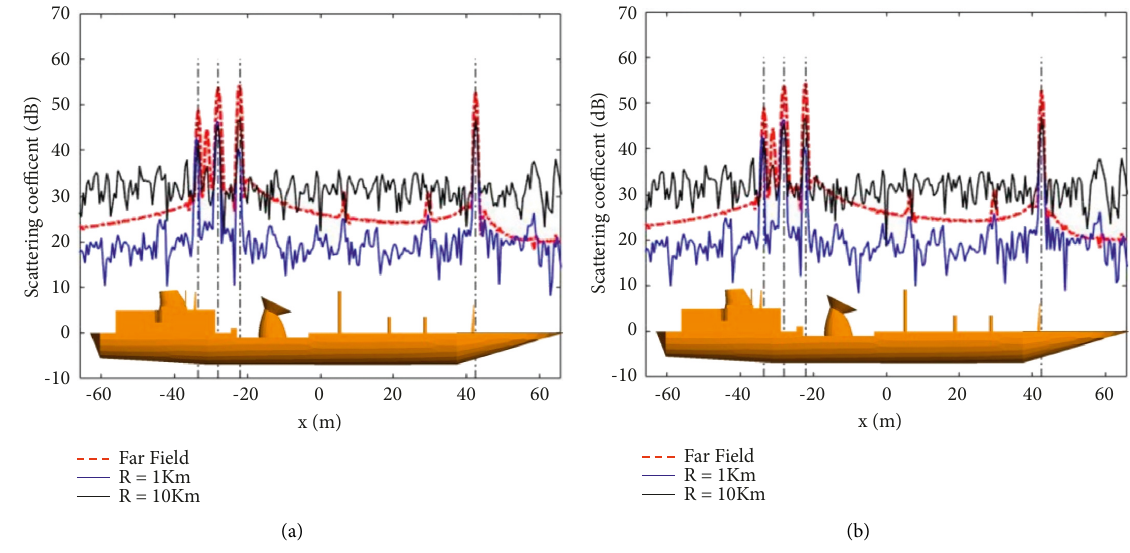
Figure 5: High-resolution range profile (HRRP) at different distances. (a) HH polarization. (b) VV